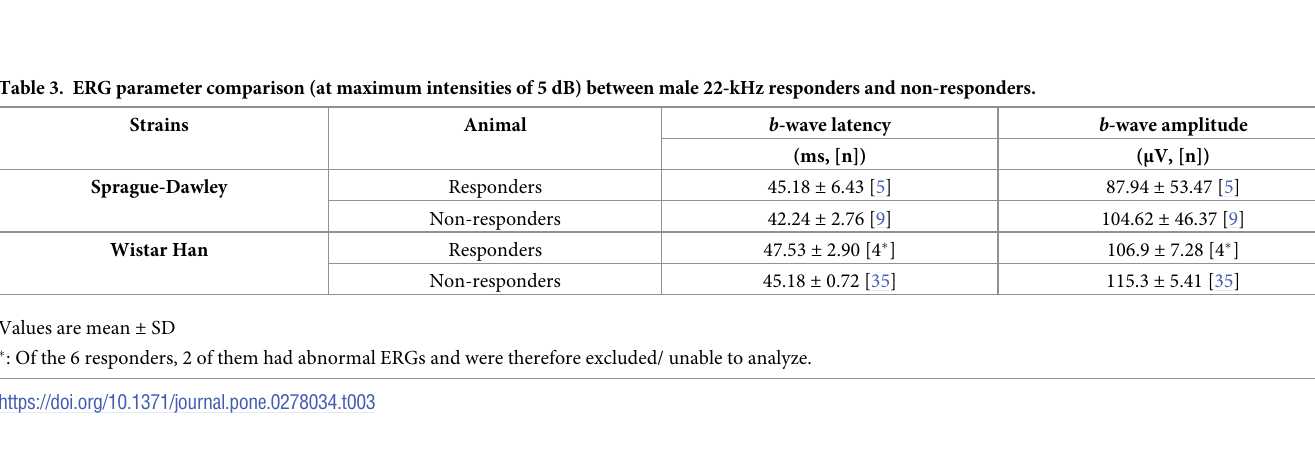
Fig 2. Representative spectrograms of 22-kHz USVs emitted by an adult SD rat. (A) the waveform of the vocalization signals (in voltage) captured during the baseline, hand-in-cage, and hand-out phases. (B) short sections of the spectrogram of the above signals show a typical sequence expanded in the X-axis in the baseline phase (C) and hand-in cage phase (D). Note the 22-kHz USVs signals in (D) but absent in (C). (E) and (F) show 3-dimensional graphs of USVs as shown in (C) and (D), respectively. Note the wall-like distribution of the 22-kHz USV signals in hand in cage phase (F) but not in baseline phase (E).